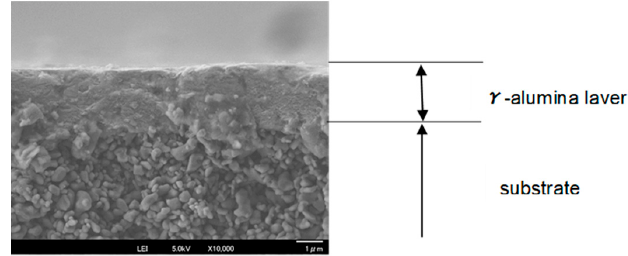
Figure 6. The SEM image of silica membrane deposited in pores of the γ -alumina layer on the substrate.